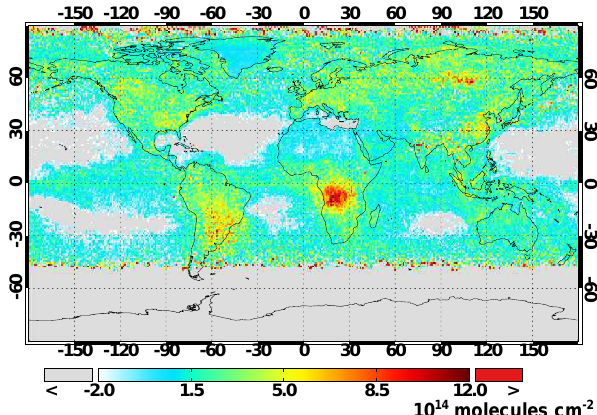
Figure 13. Monthly mean glyoxal slant column densities retrieved for July 2006 (moleculescm − 2 ).